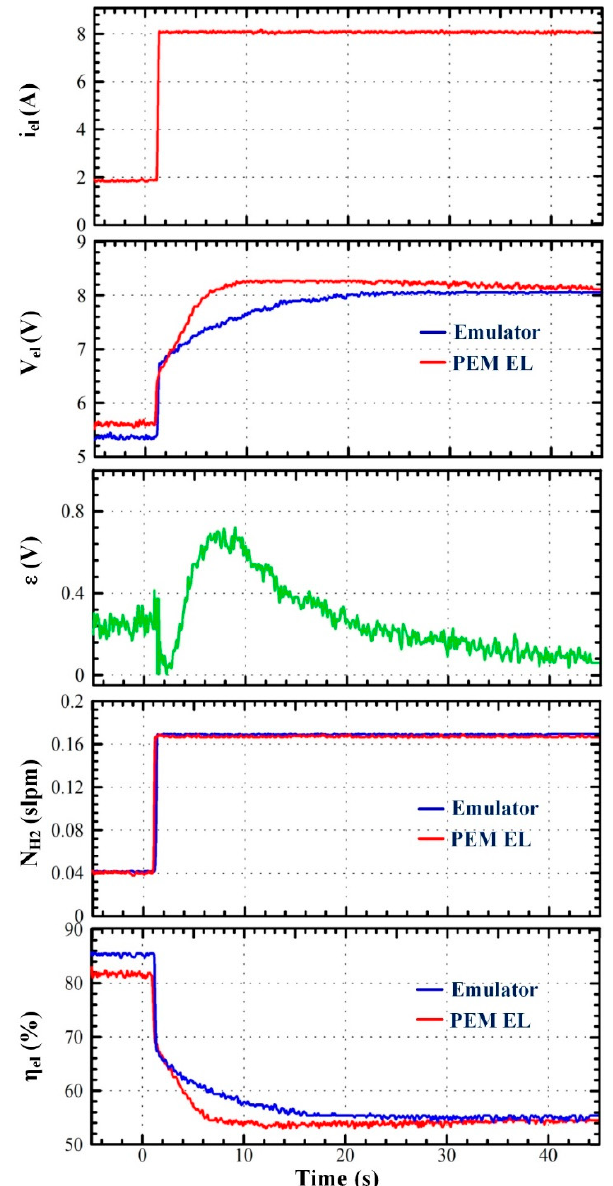
Figure 13. Comparison between the developed emulator and real electrolyzer for a step current from 2 up to 8 A.